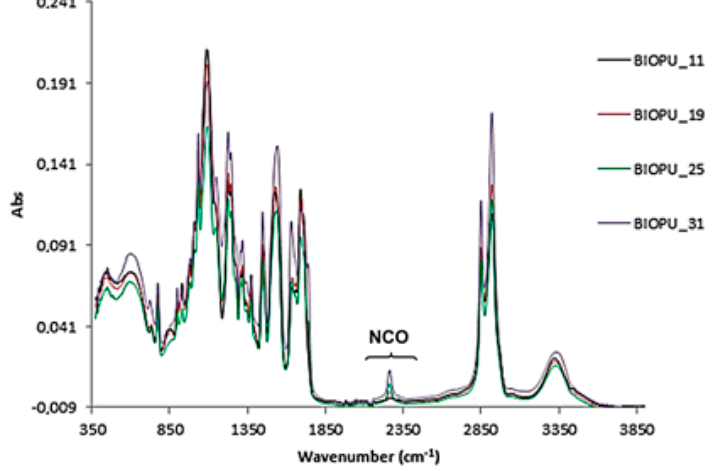
Figure 8. IR analysis of Bio-polyurethanes after 12 h.